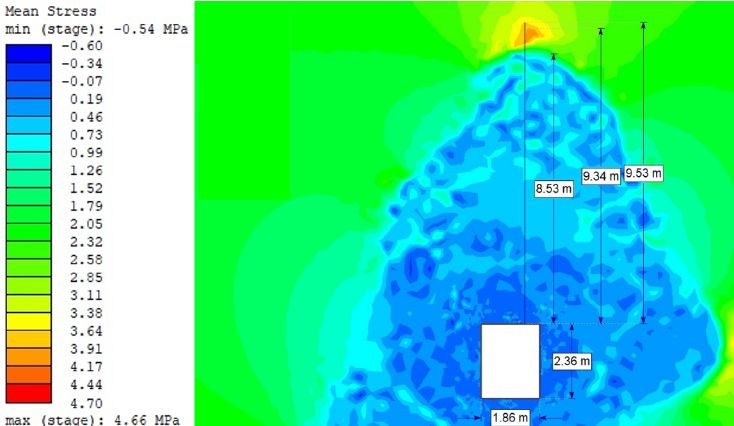
Figure 11. Mean stress for Vernier excavation without bolting (Coulomb–Mohr criterion).